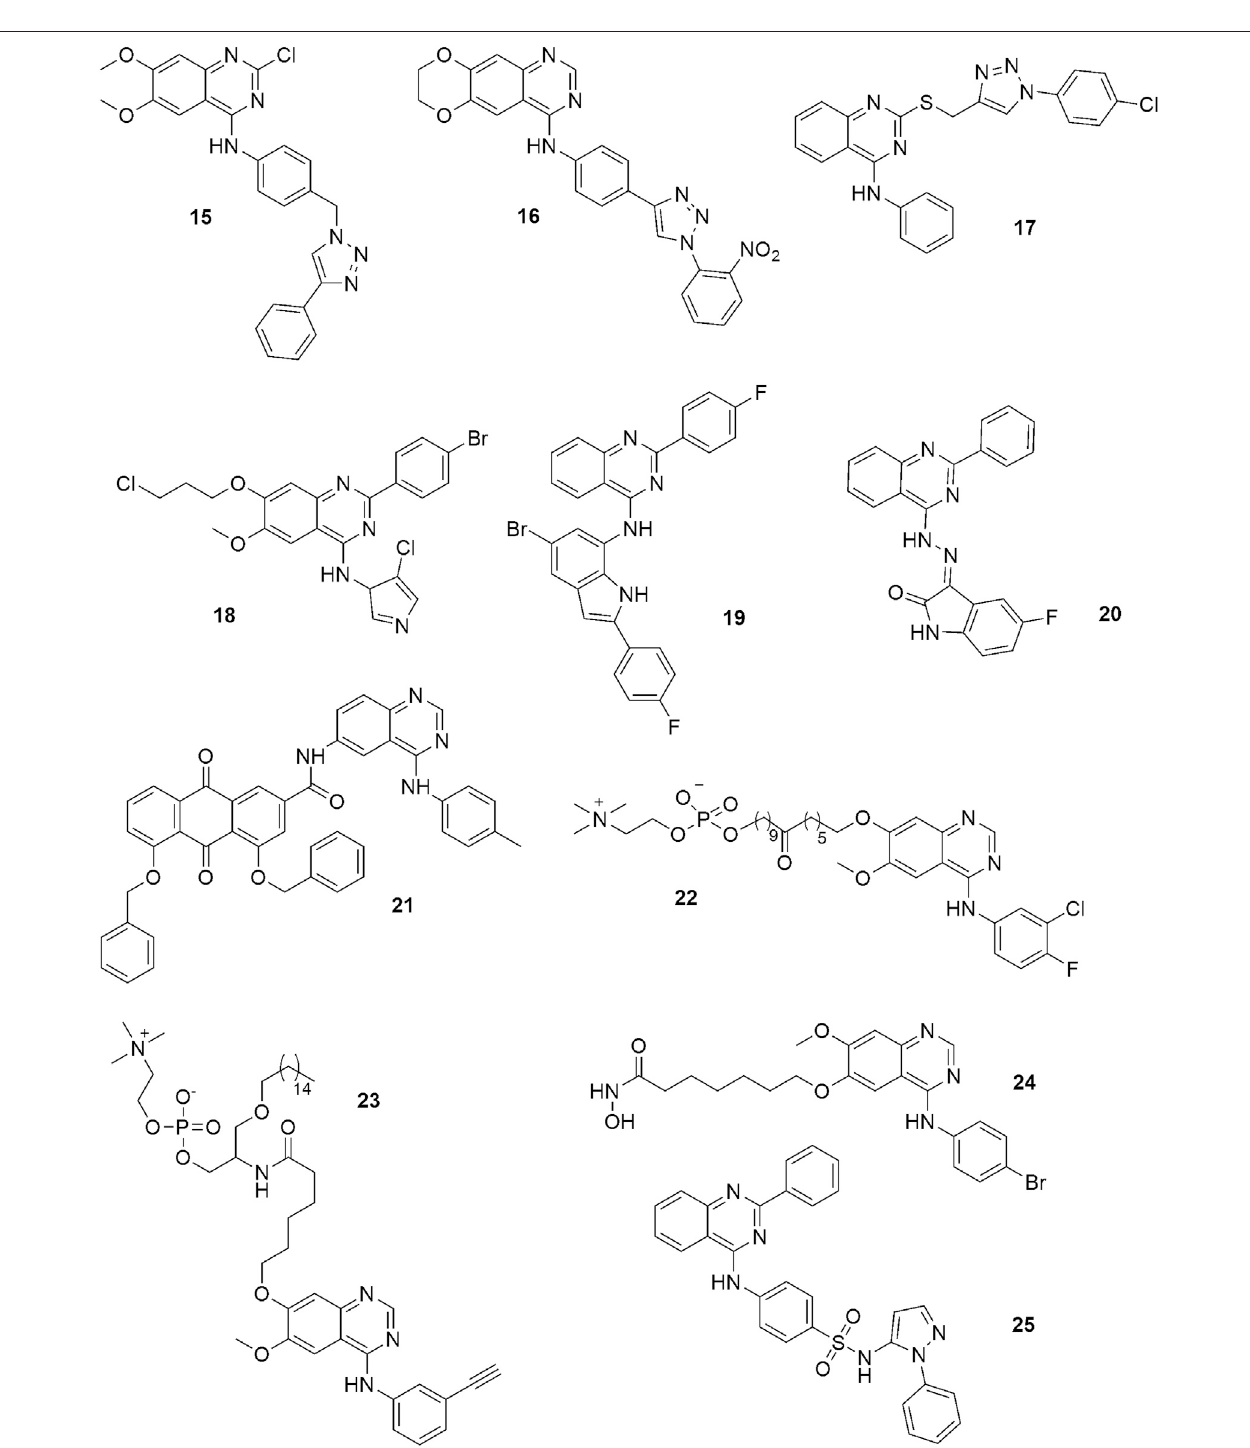
FIGURE 3 | Structures of quinazoline-based hybrid